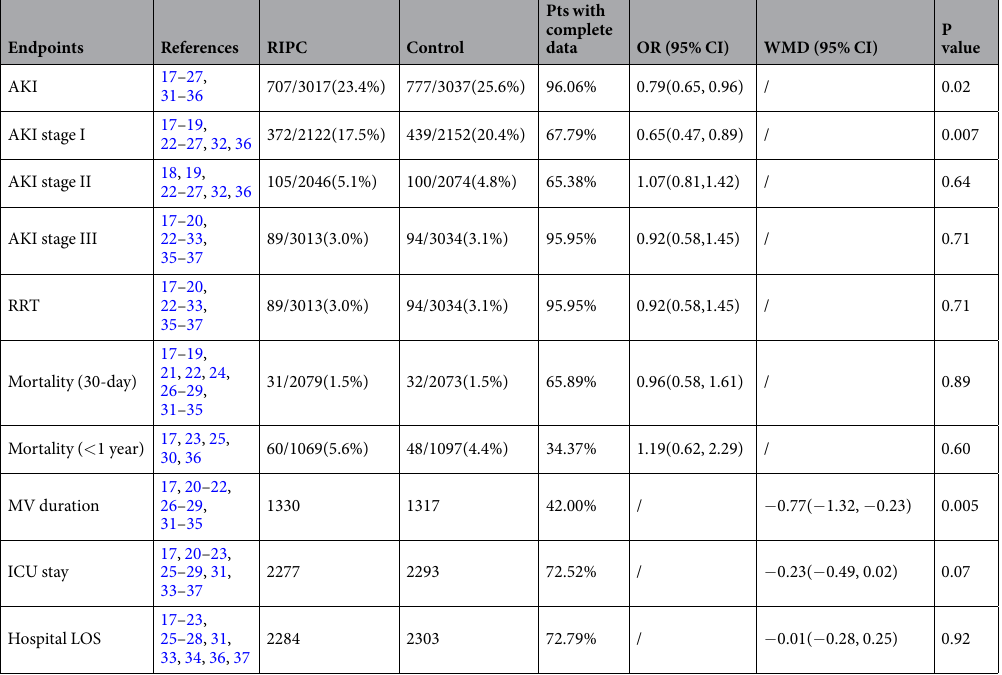
Table 3. Pooled analysis of the postoperative primary and second endpoints. Notes: AKI, acute kidney injury; RRT, renal replacement treatment; MV duration, mechanic ventilation duration; ICU stay, intensive care unit stay; Hospital LOS, hospital length of stay; Pts, patients; OR, odds ratio. WMD, weighted mean difference; CI, confidence interval; RIPC, remote ischemic